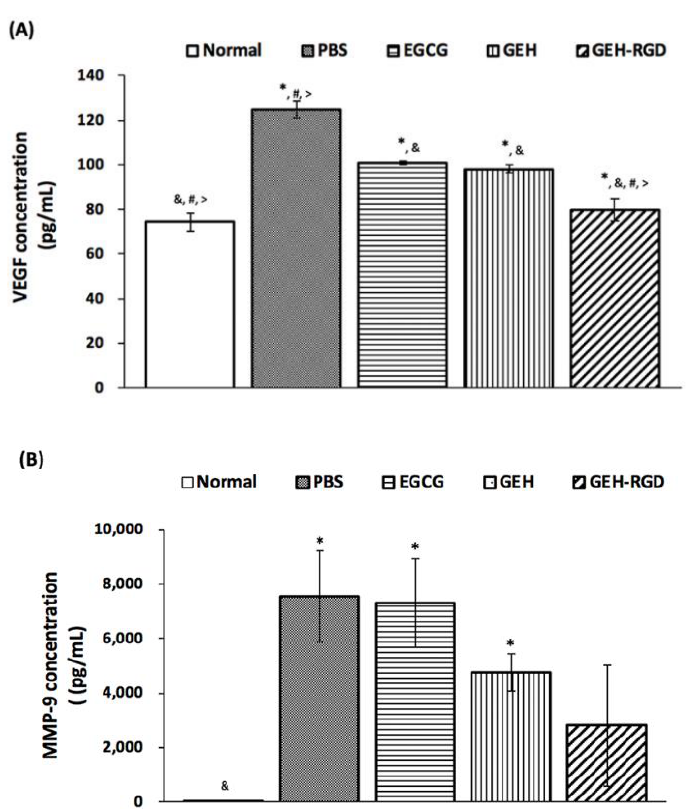
Figure 6. GEH-RGD NPs inhibit the expression of angiogenic factors in the cauterized cornea. Mice received chemical cauterization and were treated with PBS, EGCG, GEH NPs, GEH-RGD NPs-contained eye drops once daily for 7 days. The corneas were harvested and homogenized, and the protein level of ( A ) VEGF or ( B ) MMP-9 were assayed by ELISA (6 eyeballs / group from two batches). (* p < 0.05 compared with control, & p < 0.05 compared with PBS, # p < 0.05 compared with EGCG, > p < 0.05 comparedwithGEH).Abbreviation: PBS:Phosphatebu ff ersaline, EGCG:epigallocatechin-3gallate, HA: hyaluronic acid, RGD: arginine-glycine-aspartic acid, GE: Gelatin / EGCG self-assembling nanoparticles (NPs), GEH: GE NPs with HA surface coating, GEH-RGD: GE NPs with HA-RGD surface decoration. MMP: metalloproteinase, VEGF: vascularization endothelium growth factor, ELISA: enzyme-linked immunosorbent